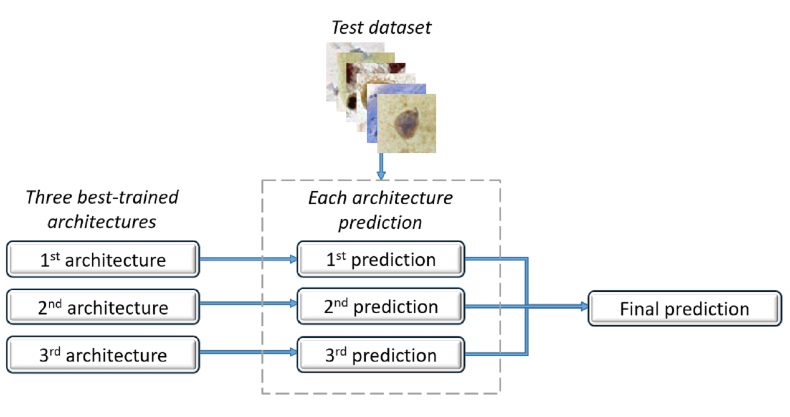
Figure 4. Proposed